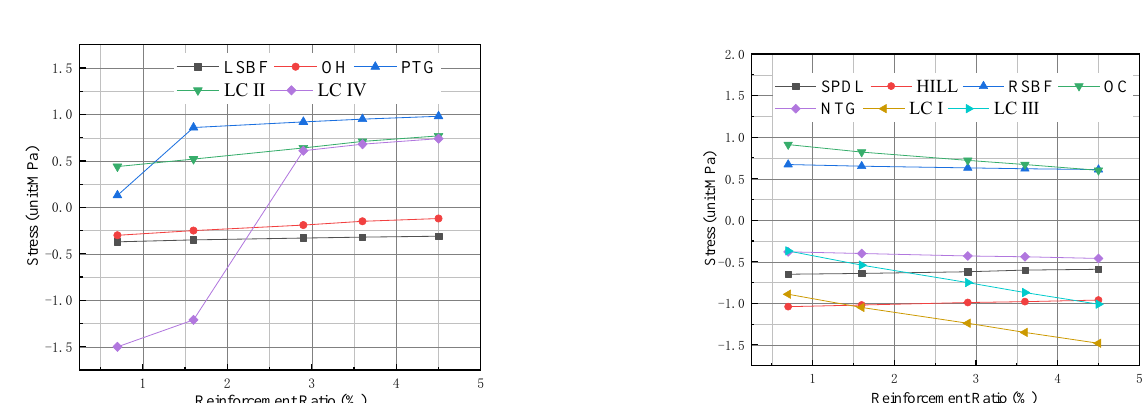
( b ) Maximum compressive stress on upper surface